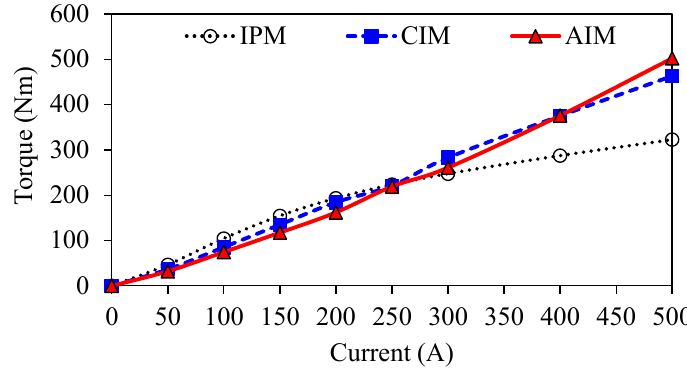
Figure 8. Variation of current angle (for IPM machine) and slip percentage (for IMs) with respect to peak current. Figure 9. Comparison of torque production capabilities.